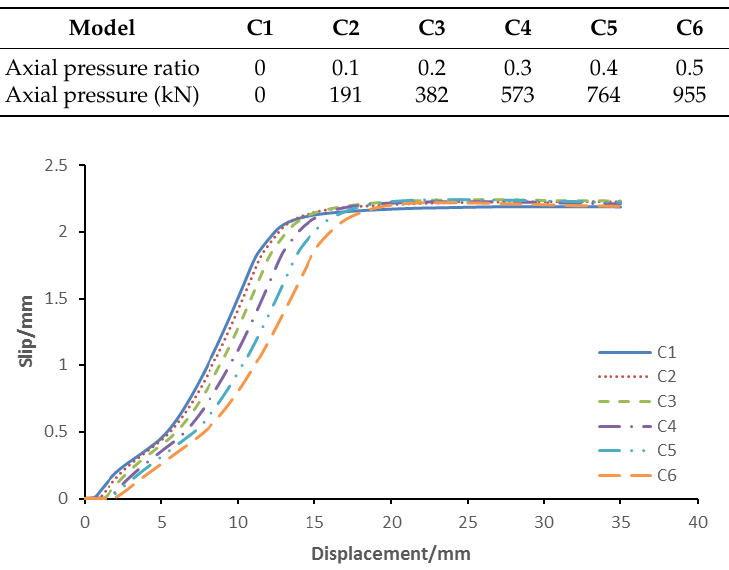
Figure 23. Slip-displacement curves.